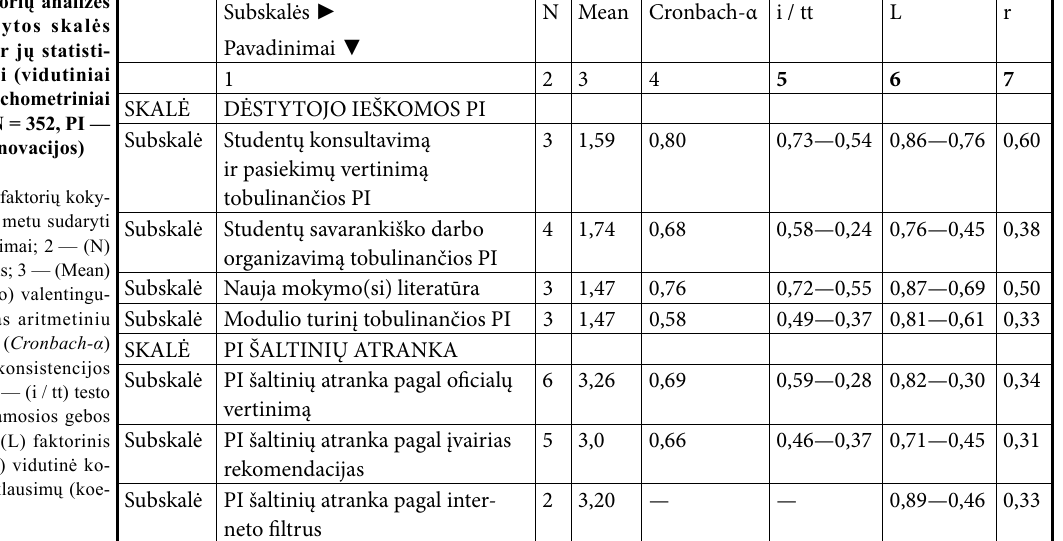
vidurkiu; 4 — ( Cronbach- α ) testo vidin ė s konsistencijos koe fi cientas; 5 — (i / tt) testo žingsnio skiriamosios gebos rodiklis; 6 — (L) faktorinis svoris; 7 — (r) vidutin ė ko- reliacija tarp klausim ų (koe- fi